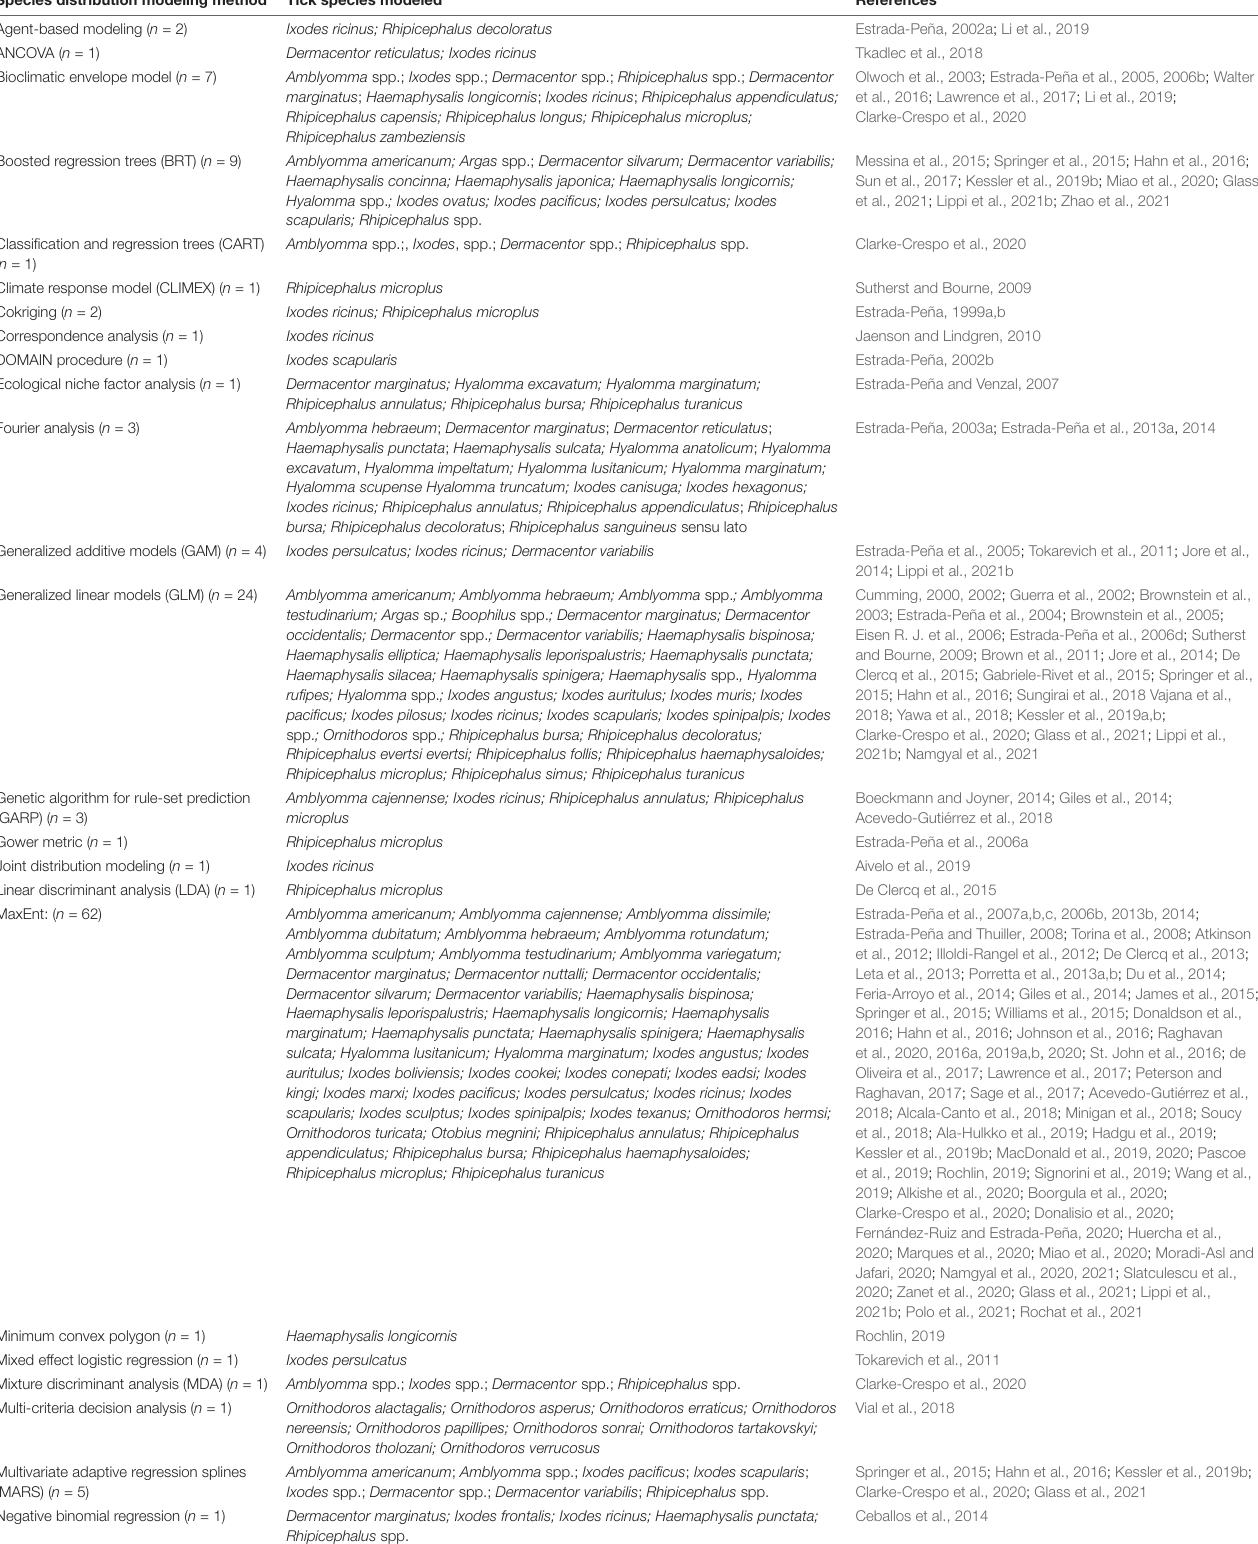
TABLE 2 | Summary of species distribution modeling methods and associated tick species represented among studies that met scoping review inclusion criteria. Species distribution modeling method Tick species